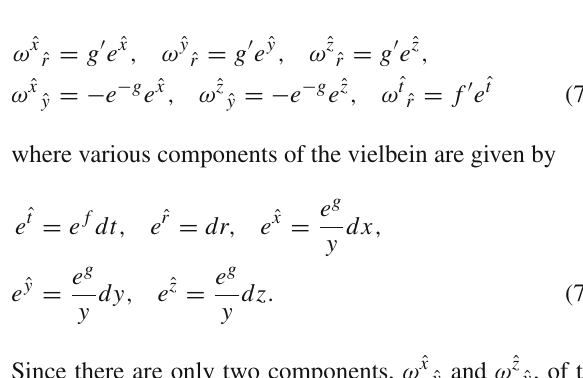
Fig. 3 An RG flow from AdS 5 critical point with U ( 1 ) × SU ( 2 ) × SU ( 2 ) symmetry to AdS 3 × S 2 critical point I for g 1 = 1, g 3 = 2 g 1 and a 5 = 1